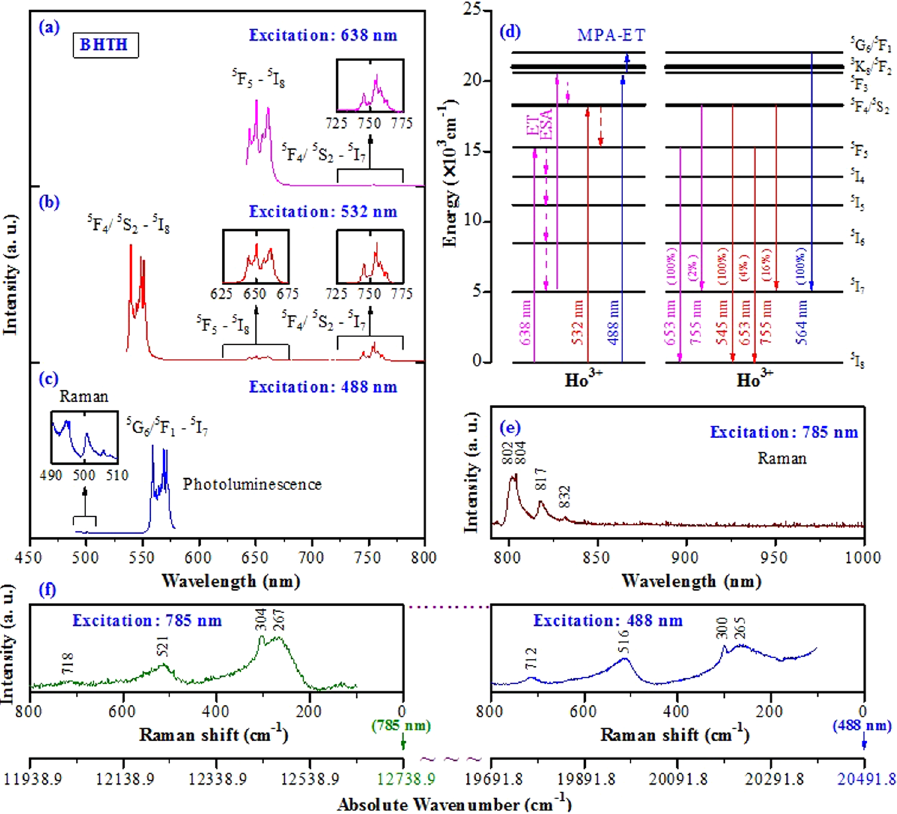
Figure 2. PL spectra of BHTH at room temperature, excitation with ( a ) 638-, ( b ) 532-, and ( c ) 488-nm laser lines. ( d ) Energy level diagram for Ho 3 + ions in BHTH. MPA-ET represents multi-phonon assisted energy transfer. The values in bracket represent the percentage of the line intensity to the strongest emission line intensity. ( e ) Pure Raman spectrum is observed using 785-nm excitation wavelength. ( f ) Comparison of Raman spectra (stokes components) under 785- and 488-nm excitation wavelengths, shown in Raman shift and absolute wavenumber. The right figure shows the weak bands at around 500 nm in Fig. 2c